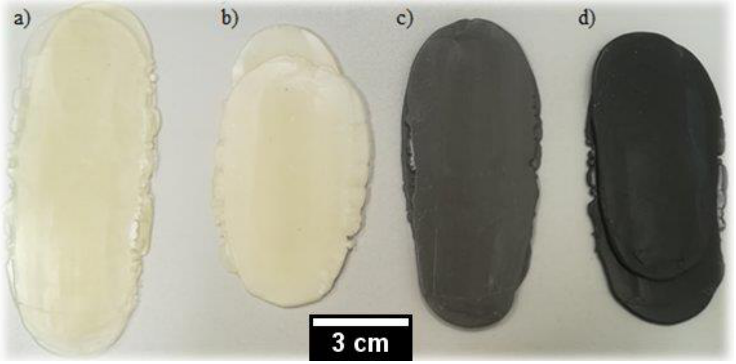
Figure 1. Prepared samples: ( a ) 100% PLA; ( b ) PLA-5% PE; ( c ) PLA-5% Mg; ( d ) PLA-5% Fe.